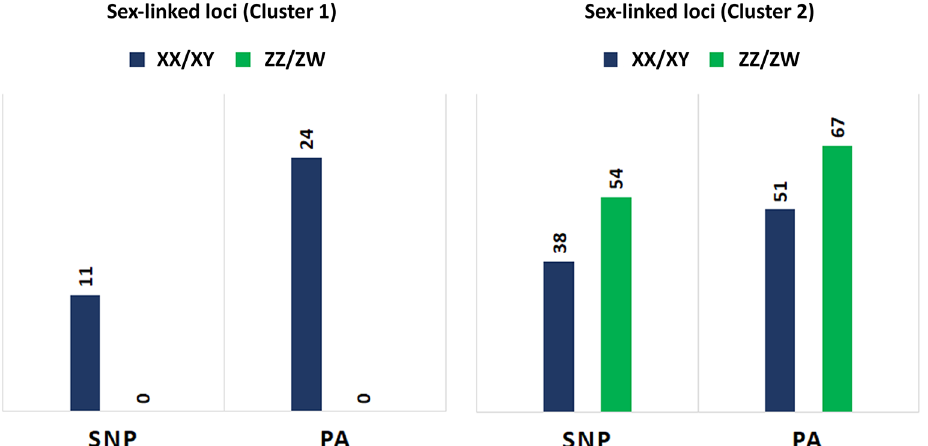
Figure 2. Number of sex-linked Single Nucleotide Polymorphism (SNP) and Presence–Absence (PA) loci in two clusters of Platyplectrum ornatum . XX/XY denotes markers supporting a male heterogametic sex determination system. ZZ/ZW denotes markers that support a female heterogametic sex determination system.